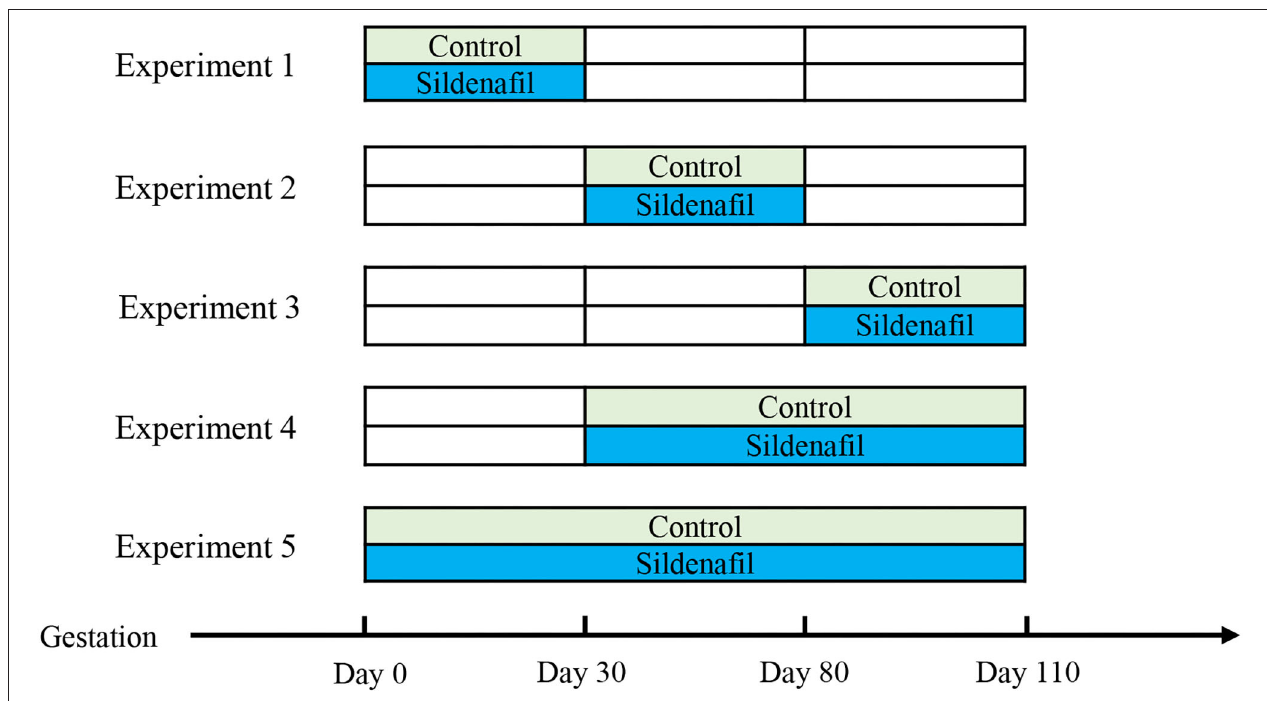
FIGURE 1 | Schematic representation of the experimental design based on the different timing of sildenafil supplementation during gestation.